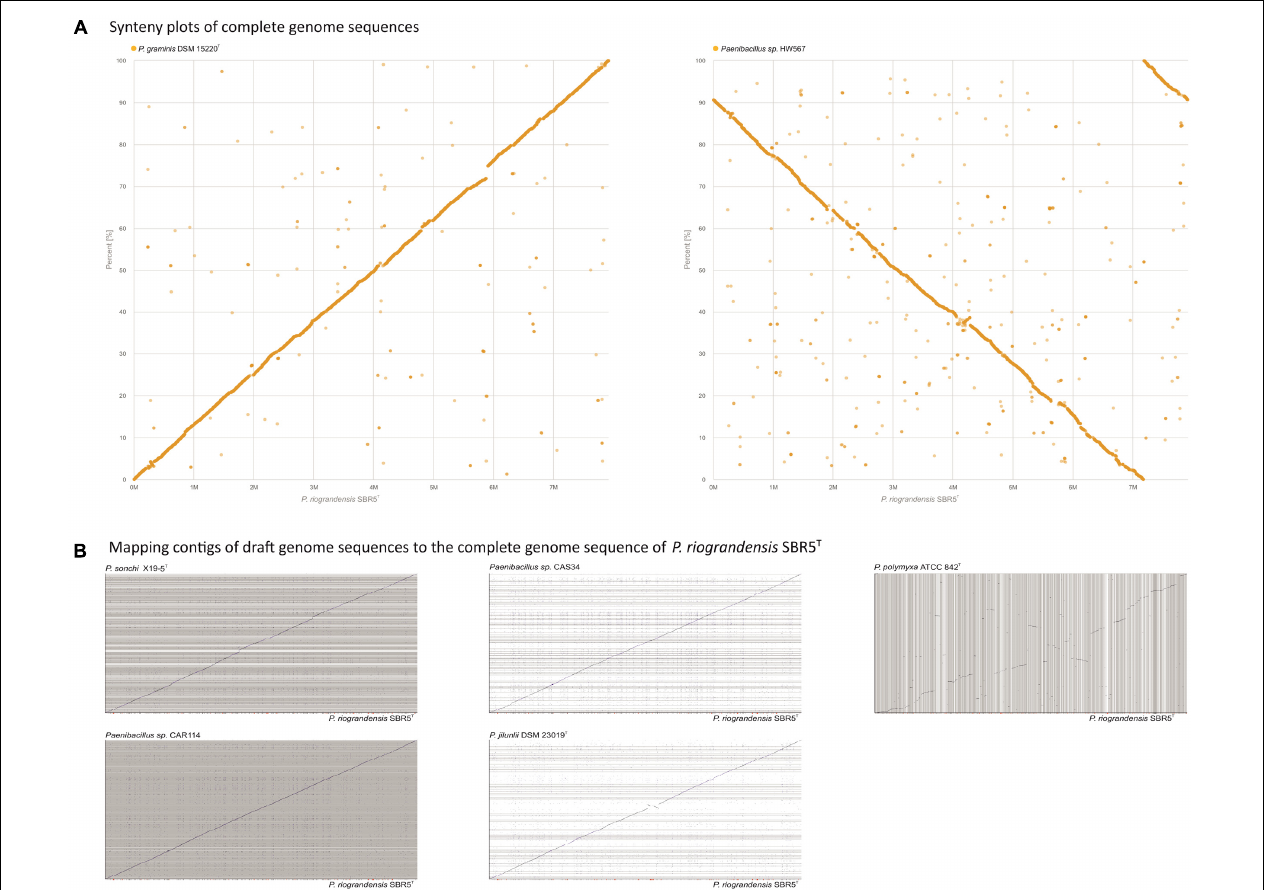
FIGURE 2 | Synteny analysis of P. riograndensis SBR5 T and the complete genome sequences of related species (A) , and mapping of draft genome sequences of related species to the P. riograndensis SBR5 T genome (B) . Blue line denotes syntenic scaffold alignments. The horizontal bar at the bottom indicates coverage of the matches to the reference scaffold, SBR5 T , with maximal coverage indicated with black, fading to light gray with less coverage. Red indicates uncovered regions.